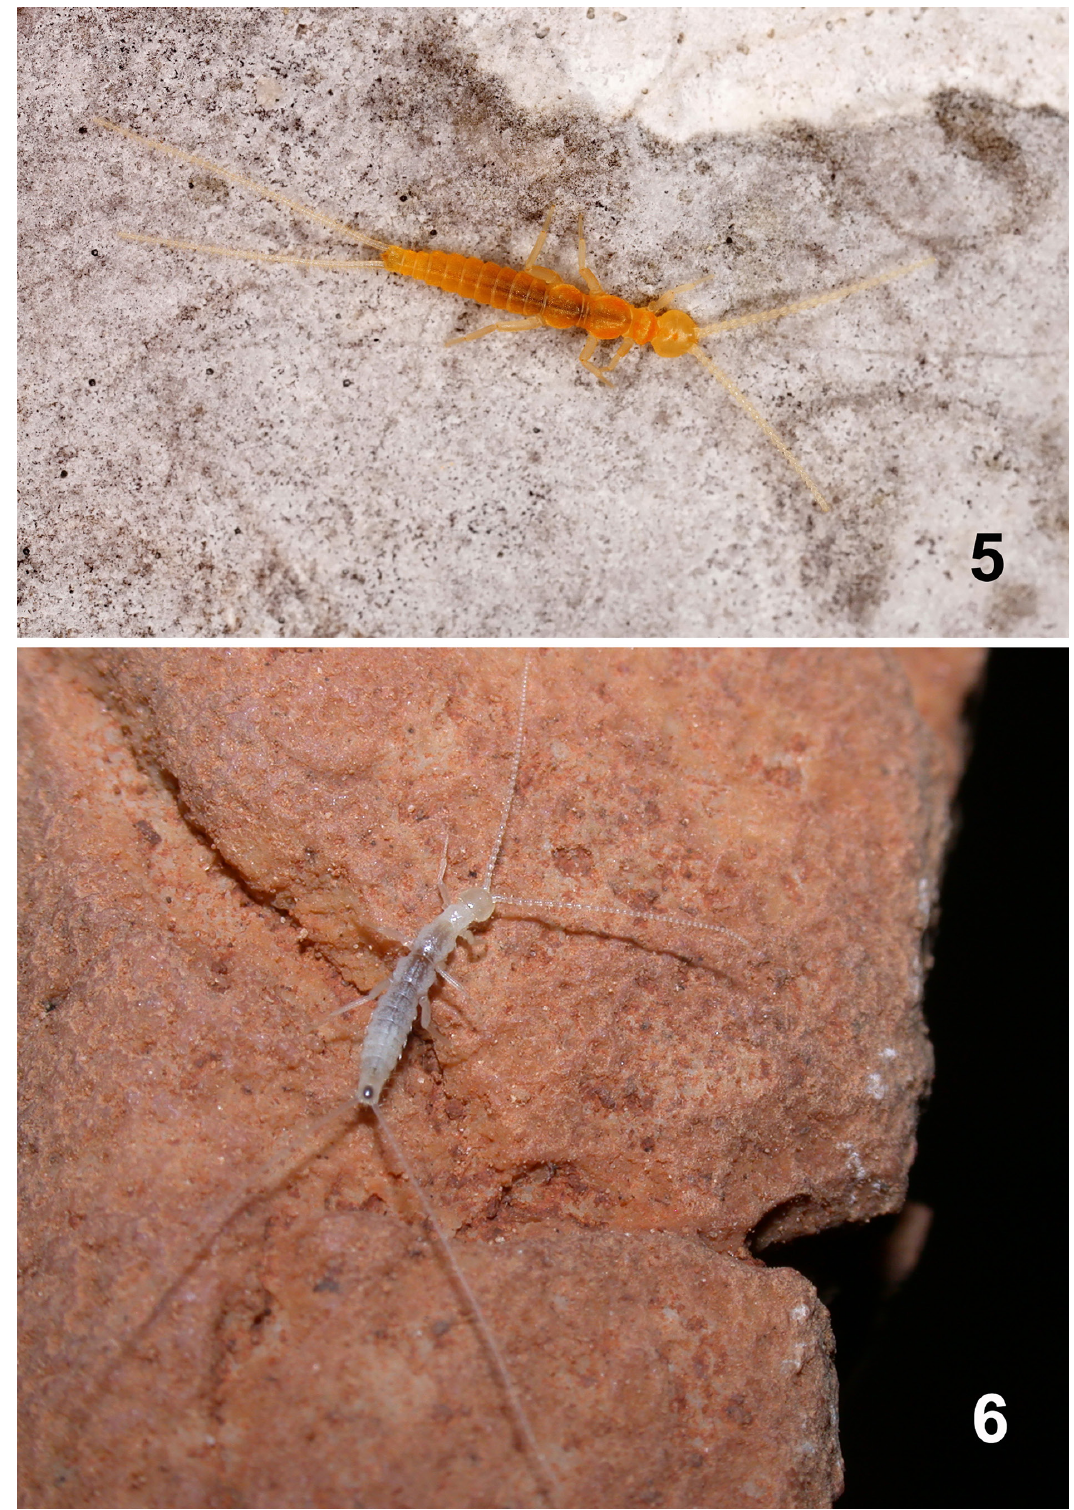
Figs 5–6. Campodeidae in their natural environment. 5 . Campodea ( Campodea ) tuxeni Wygodzinsky, 1944, Hartelsgraben valley, Hieflau, Styria, Austria (photograph by Christian Komposch). 6 . Campodea ( Campodea ) maestrazgoensis Sendra & Escolà, 2004 in Cova del Mas Nou cave, Coves de Virrromà, Castellò, Iberican Mounta in Range, East of the Iberian Peninsula (photograph by Sergio